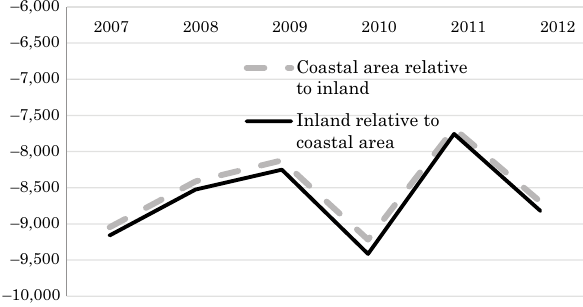
Fig. 6. Conditional estimated parameters ξ